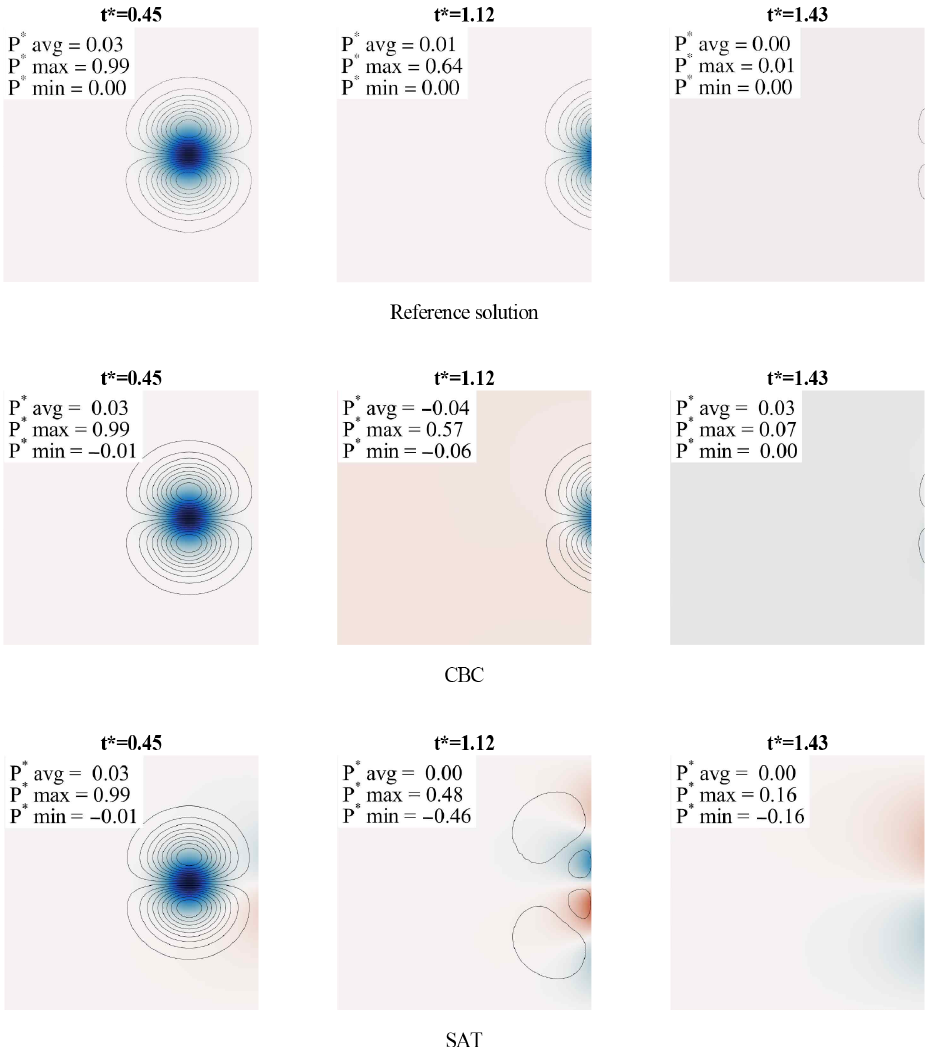
Figure 10. Simulation results for two-dimensional vortex case using SAT and CBC compared with reference solutions. ( top row ) Reference solutions, ( middle row ) obtained results by using CBC, and ( bottom row ) obtained results by using SAT for three time